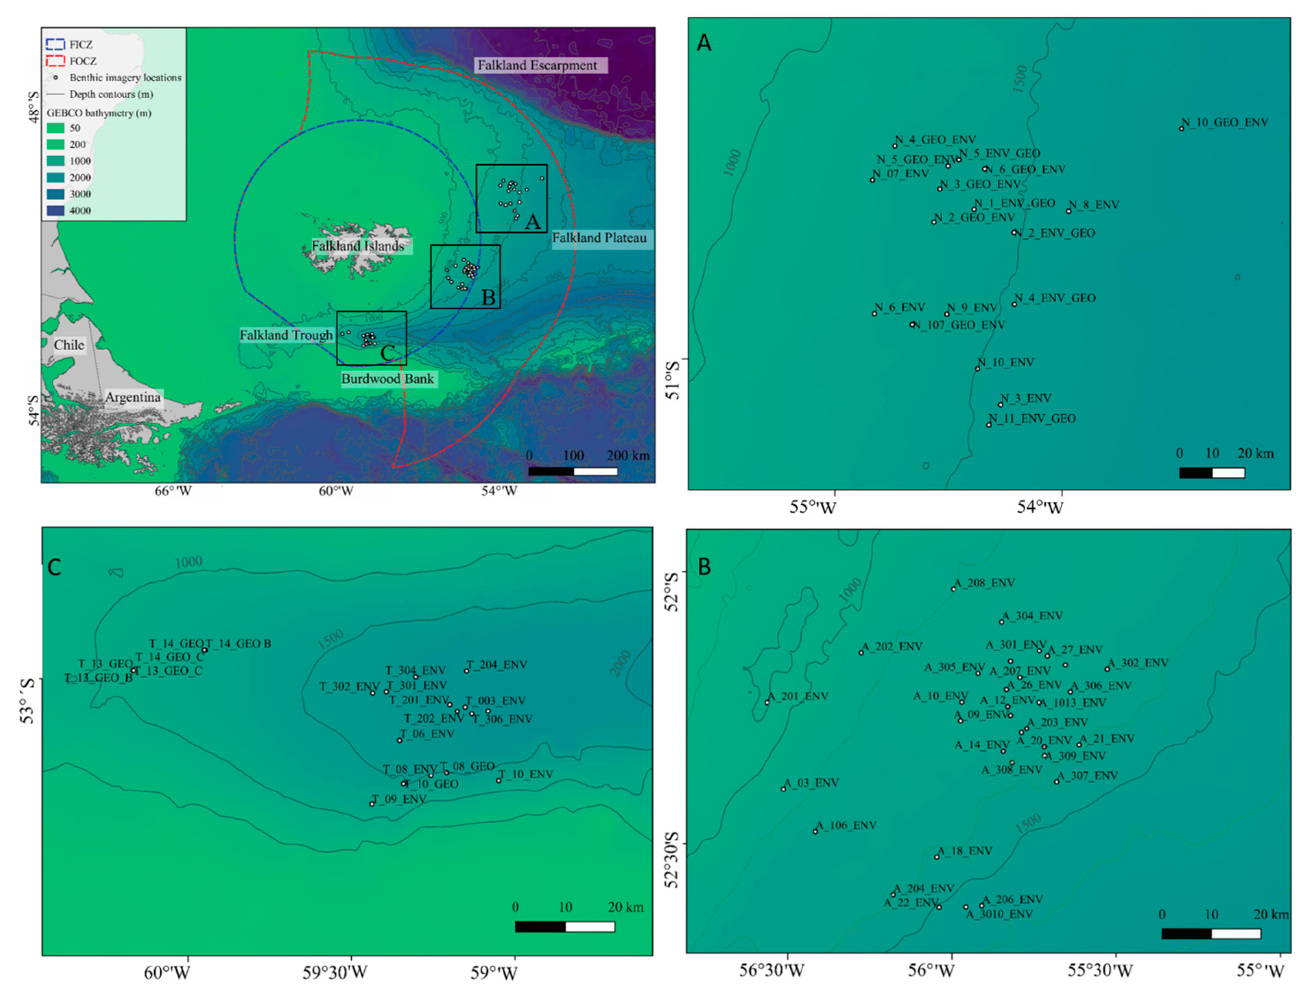
Figure 1. Location map of the Falkland Islands and ( A – C ) zoomed insets of drop-down camera locations (indicated as black circles). The Falklands conservation zones encompass the Falklands Interim Conservation and Management Zone (FICZ) and the Falklands Outer Conservation Zone (FOCZ). (See Supplementary Table S1 for full station list and locations).